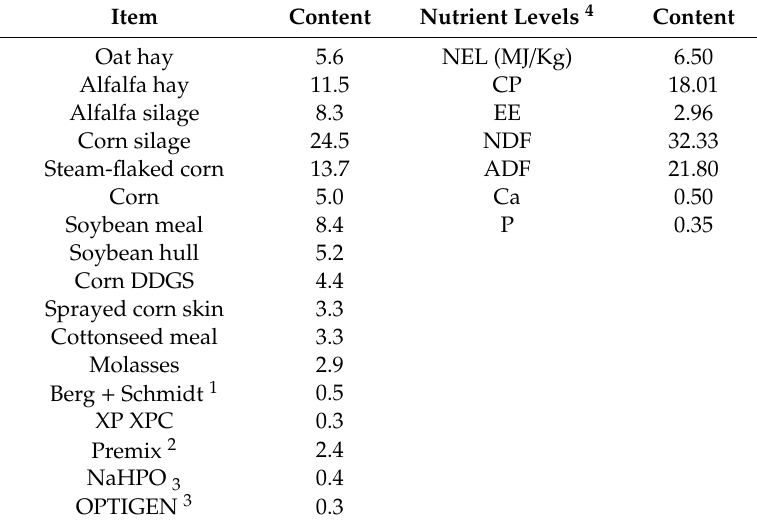
Table 2. Basic diet composition and nutrient value (DM basis